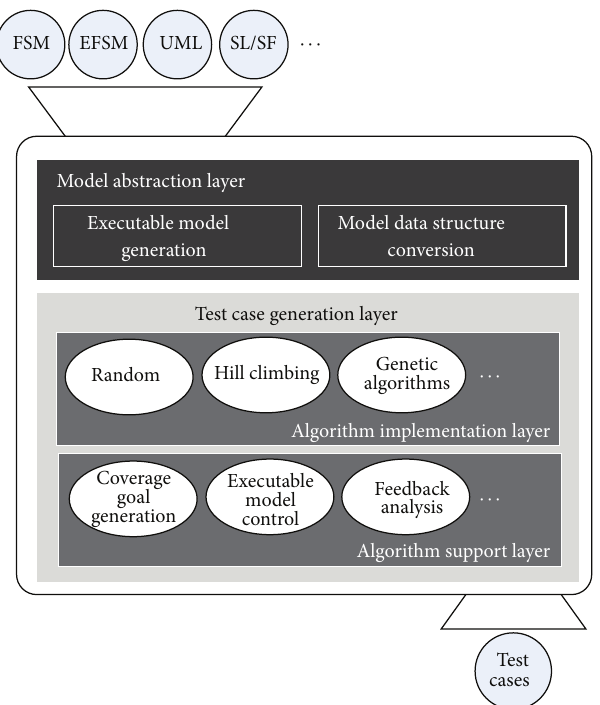
Figure 1: The architecture of a model-independent software frame-